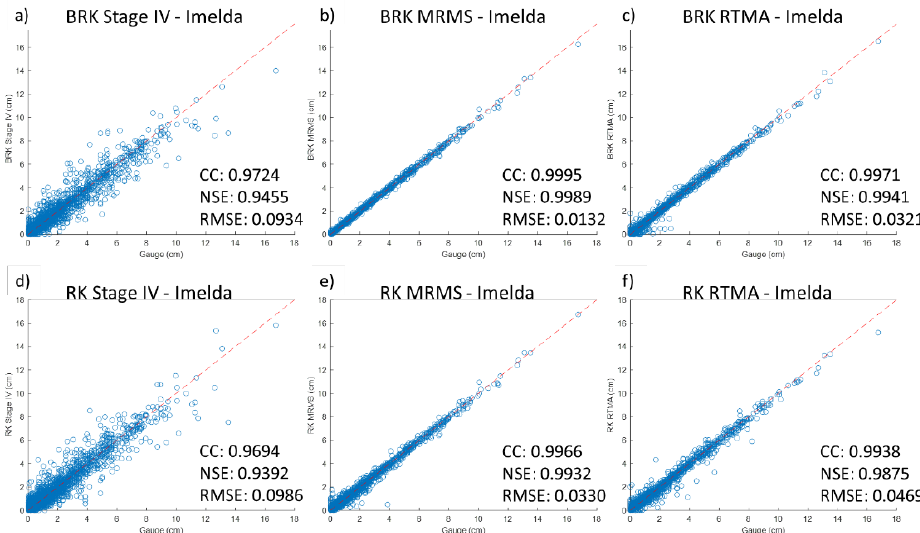
Figure 10. Scatter plots of calibration gauge data and merged radar-gauge data of ( a ) Stage IV, ( b ) MRMS, ( c ) RTMA using the BRK method, ( d ) Stage IV, ( e ) MRMS, and ( f ) RTMA using the RK method during Tropical Storm Imelda.